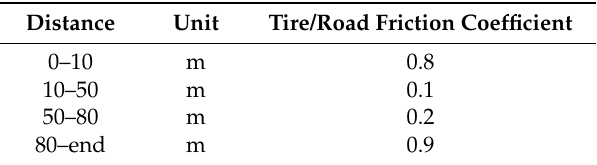
Table 4. Road surface input for front